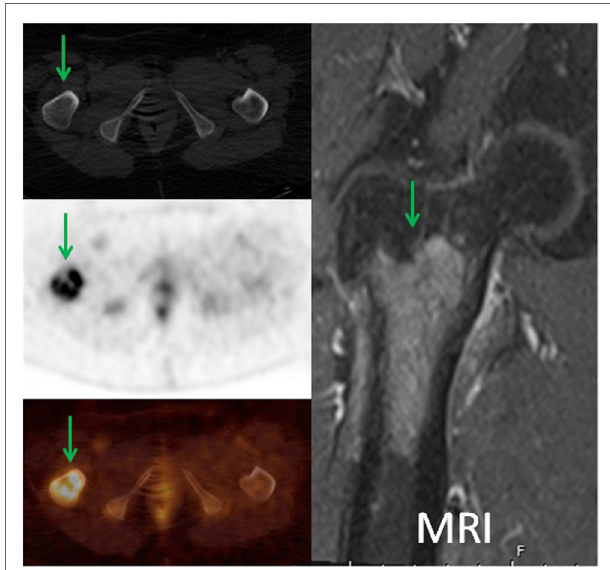
FigUre 5 | a 57-year-old female diagnosed with chronic myelogenous leukemia status post allogenic bone marrow stem cell transplant and widespread disease . 18F-FDG PET demonstrated intense focal uptake in the intertrochanteric region of the proximal right femur with no corresponding bone changes in the CT (green arrows). The patient had MRI with contrast which demonstrated marrow replacing lesion. Patient received XRT, BMA, and had orthopedic fixation. In addition, 18F-FDG PET directed the biopsy site for this patient.